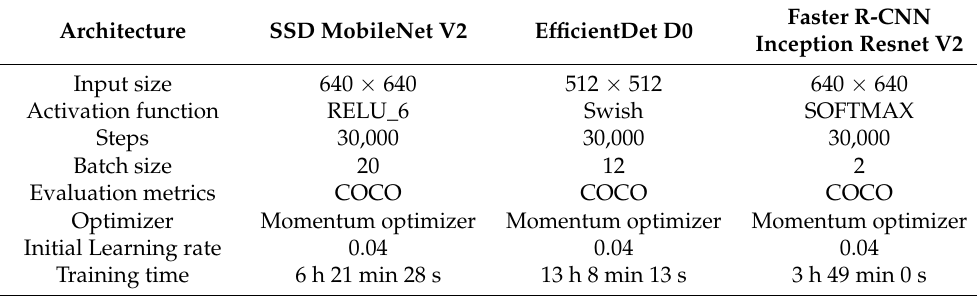
Table 3. Model configuration information.